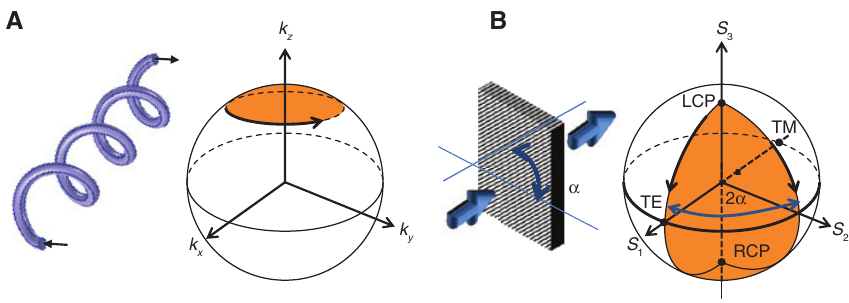
Figure 1: Geometric phases in different state spaces. (A) Light propagation in a curled fiber associated with a geometric phase in the momentum space. (B) Light propagation across a half-wave plate, with orientation angle α for its fast axis, in turning LCP to RCP, associated with a geometric phase in the polarization space. The arrows on the materials or structures show the direction of light. The arrows on the state space show the directions of the light transport